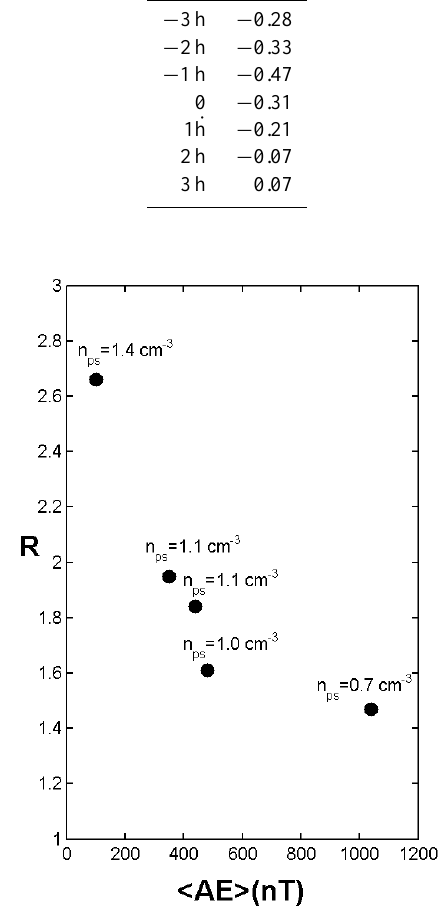
Fig. 7. The R -values versus the AE index averaged over 1h preced- ing the storm onset for the 5 intervals for which plasma sheet density data are available (from MPA instrument on the LANL satellites or- biting geosynchronously near the geomagnetic equator). Densities of high energy ions (.13–45keV) are